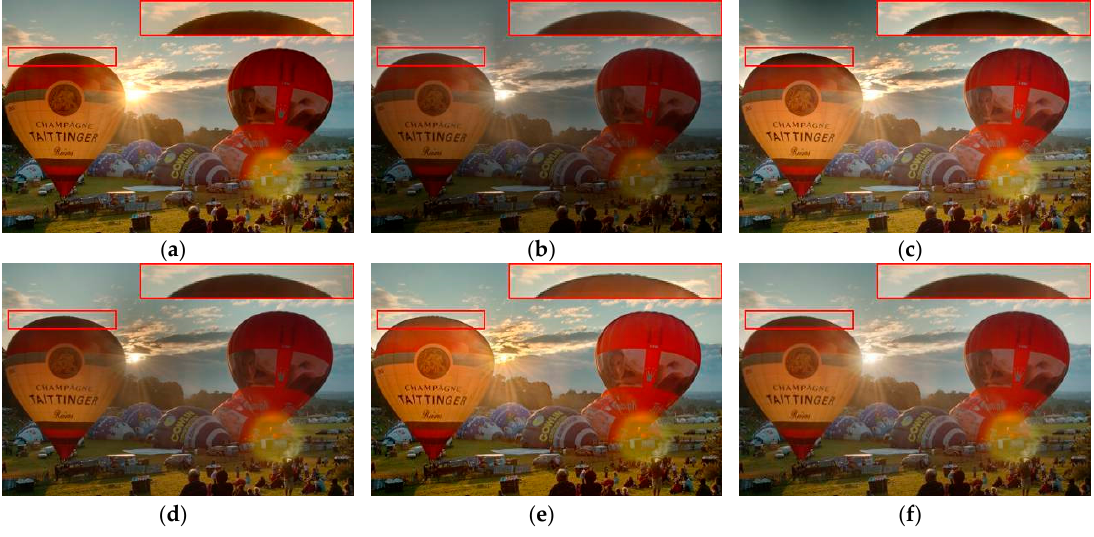
Figure 7. Performance comparison of different methods on the “balloons” image sequence. ( a ) Mertens10 [15]; ( b ) Vonikakis11 [16]; ( c ) Li13 [18]; ( d ) Liu15 [12]; ( e ) Ma18 [14]; and ( f ) the proposed method.